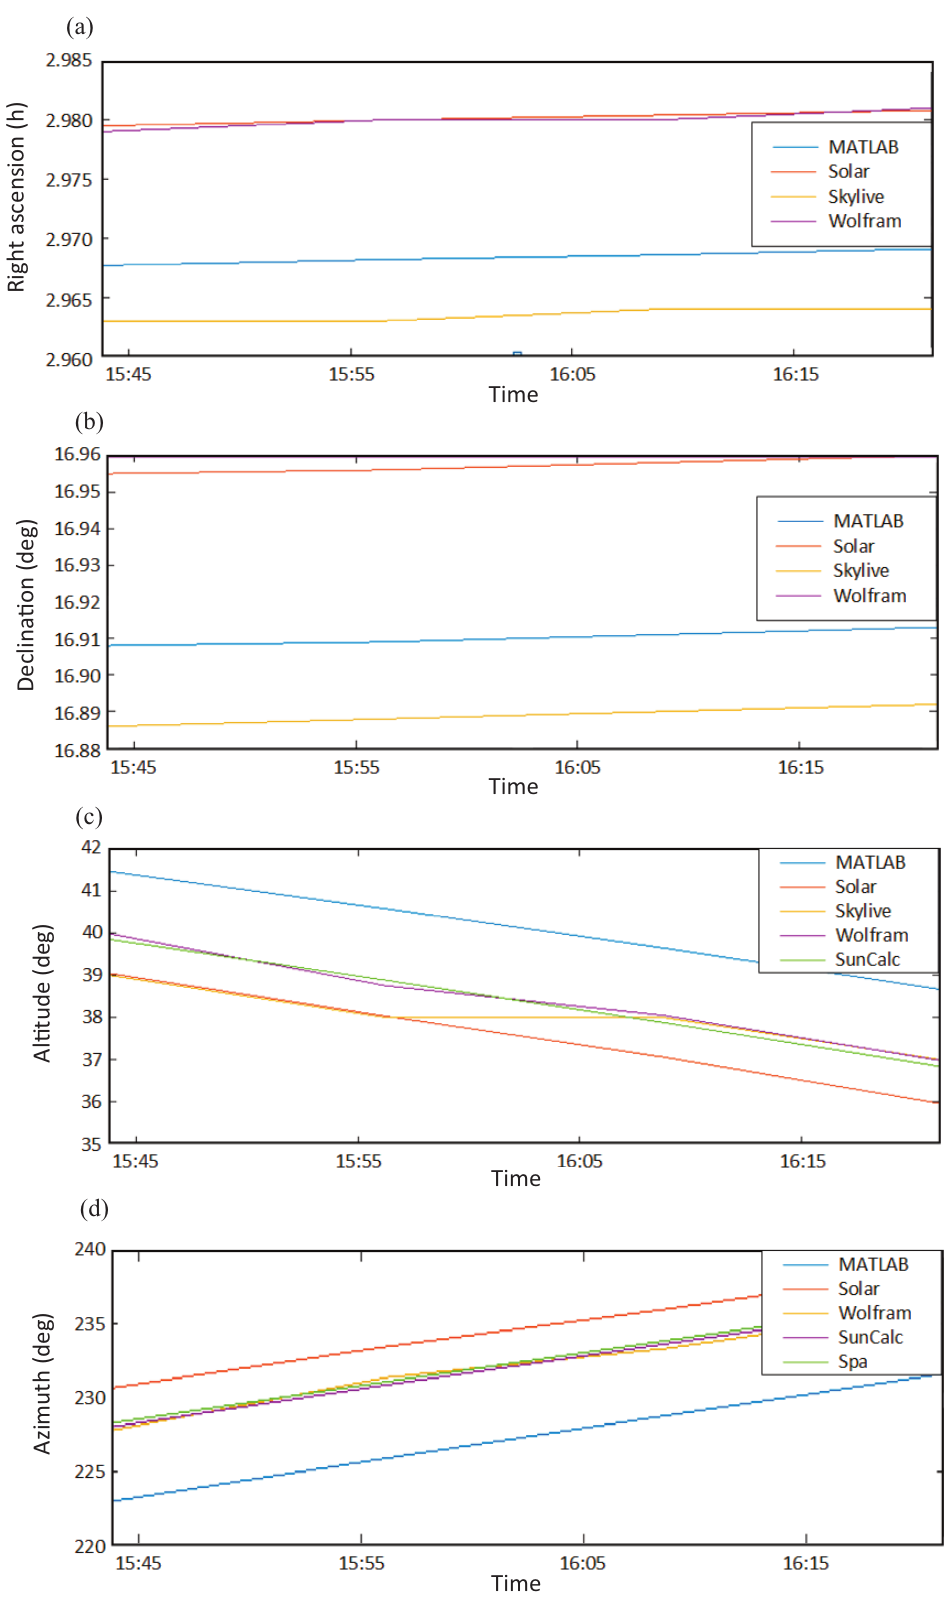
Fig. 10. Sun position algorithm verification by (a) right ascension, (b) declination, (c) altitude and (d) azimuth.